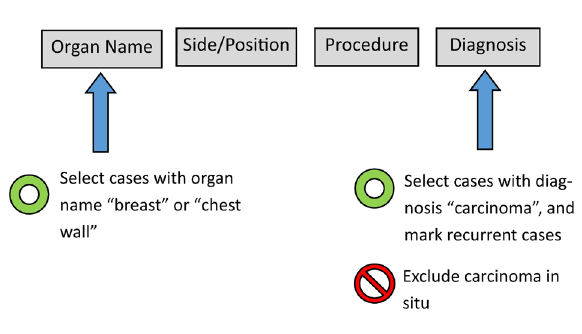
Figure 2: Protocol to search for primary and recurrent breast cancer cases.